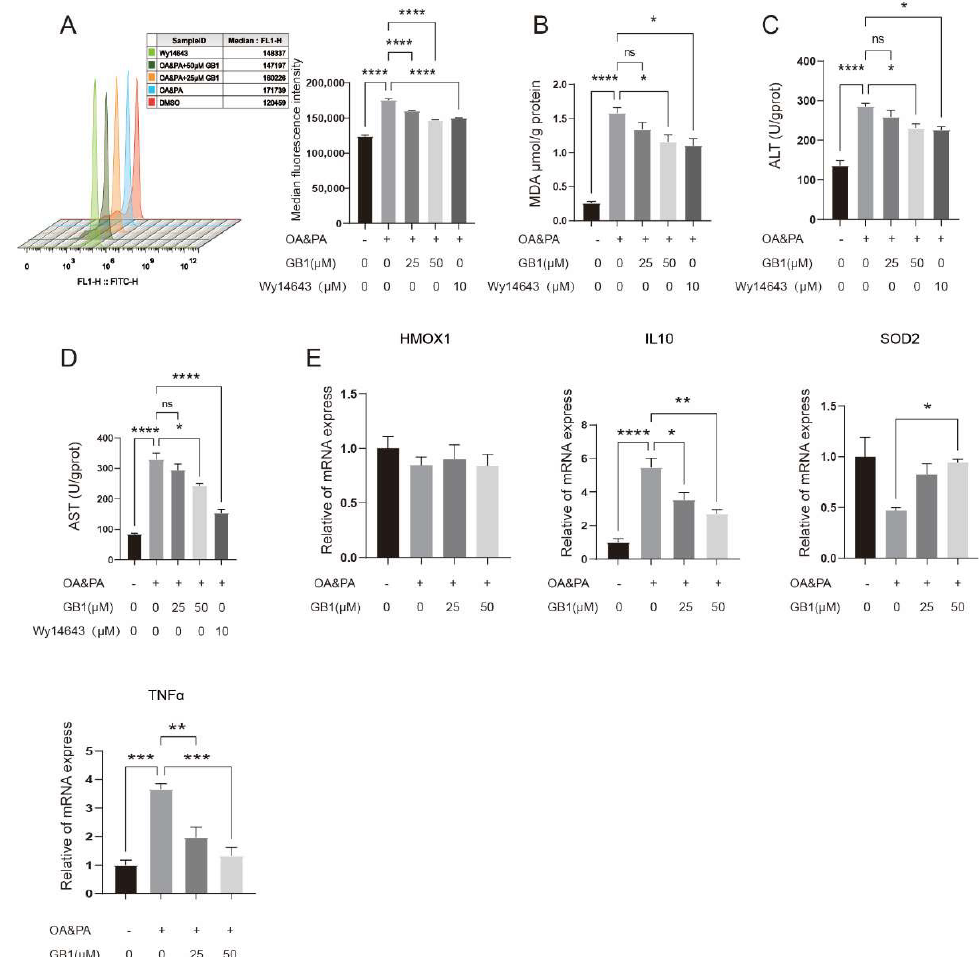
Figure 3. GB1 improves the ROS burden induced by OA&PA in HepG2 cells. ( A ) Flow cytometry showed the suppression of ROS level by GB1 treatment. ( B ) GB1 reduced the production of MDA, ALT ( C ) and AST ( D ). ( E ) GB1 suppressed apoptosis-related genes. All data were presented as mean ± SEM of three independent experiments. *, p < 0.05, **, p < 0.01, ***, p < 0.001, ****, p < 0.001; ns, not